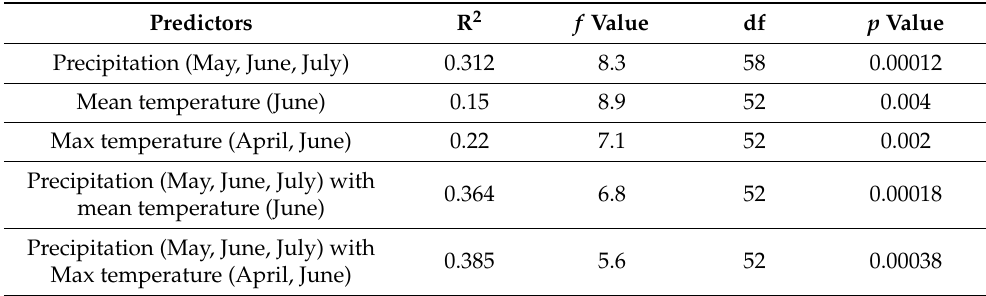
Figure 7. Response of tree-ring width to mean monthly rainfall, snow and temperature of the hy- drological year in Pertouli University Forest (significance of correlation: * p ≤ 0.05; ** p ≤ 0.01). Table 2. Results of multiple regression analysis for explaining tree-ring width variability by mean monthly precipitation and temperatures (mean, max and min) calculated for the hydrological